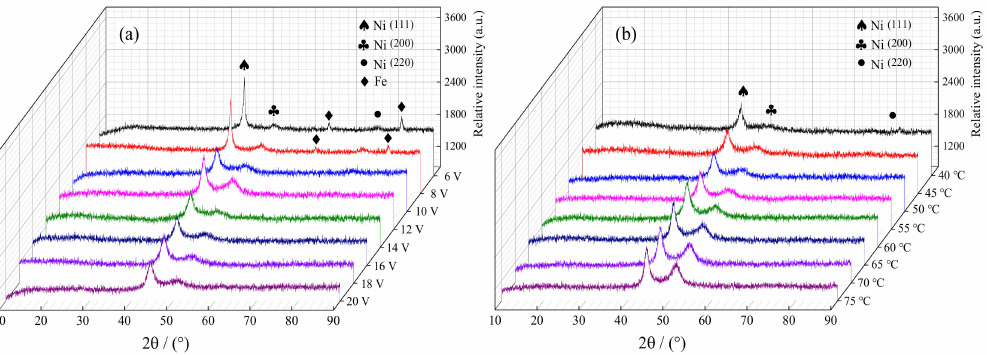
Figure 5. XRD patterns of Ni–Co–P alloy coatings as a function of: ( a ) jet voltages; ( b ) the temperature of plating solution.